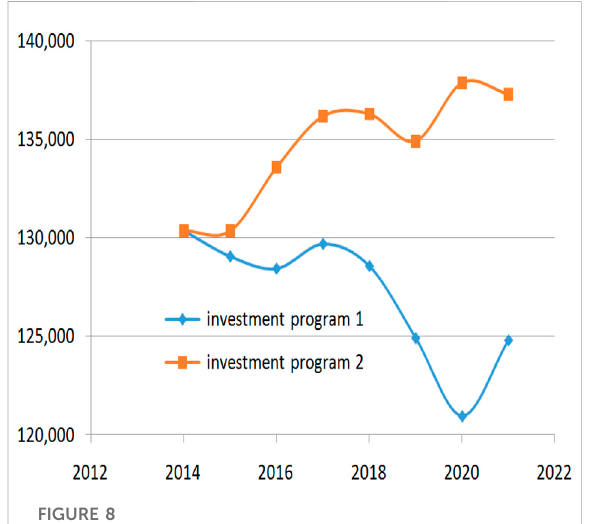
FIGURE 8 ModellingofInnovationindexdynamicsinclimatechangefor two investment programs in 2014 – 2021 in